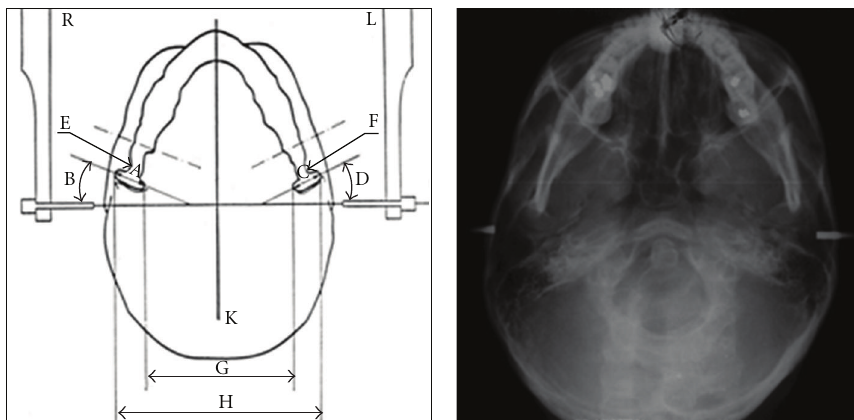
Figure 1: Scheme of the submentovertex radiograms and corresponding digital acquisition. (A) right transverse condylar width, (B) right condylar horizontal angle, (C) left transverse condylar width, (D) left condylar horizontal angle, (E) neck of the right condyle, (F) neck of the left condyle, (G) intracondylar distance, (H) extracondylar distance, (K) midline (orthogonal to the transporionic axis).